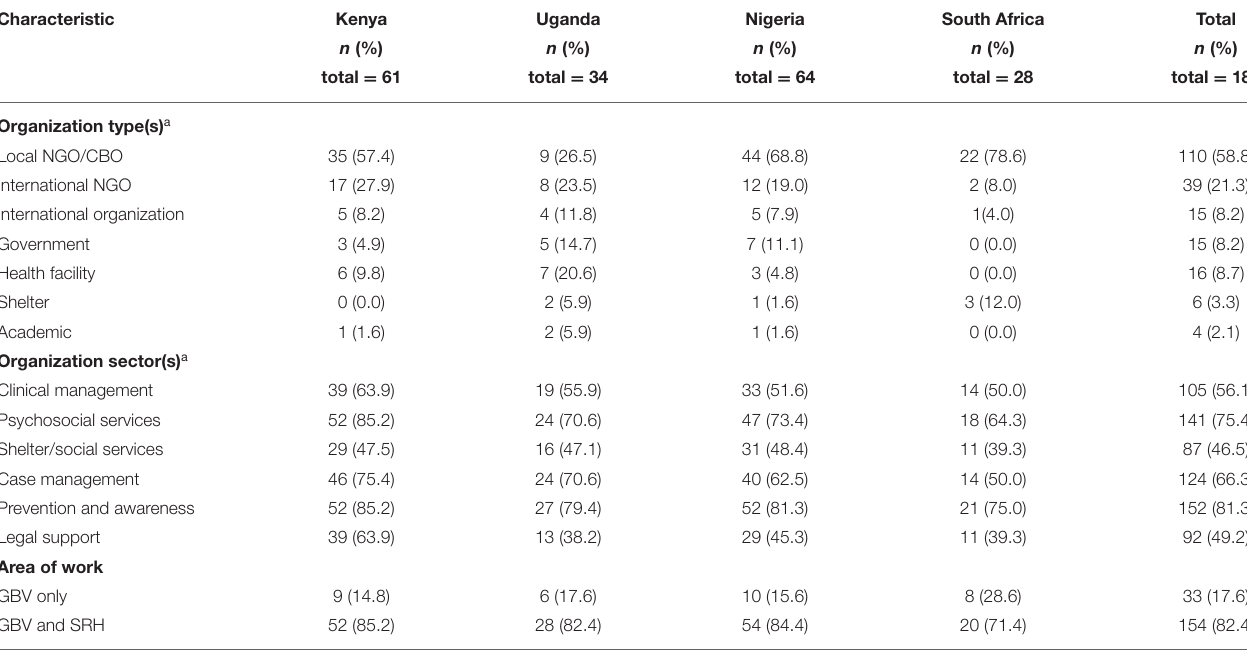
TABLE 1 | Organization type and area of work of survey respondents. Characteristic